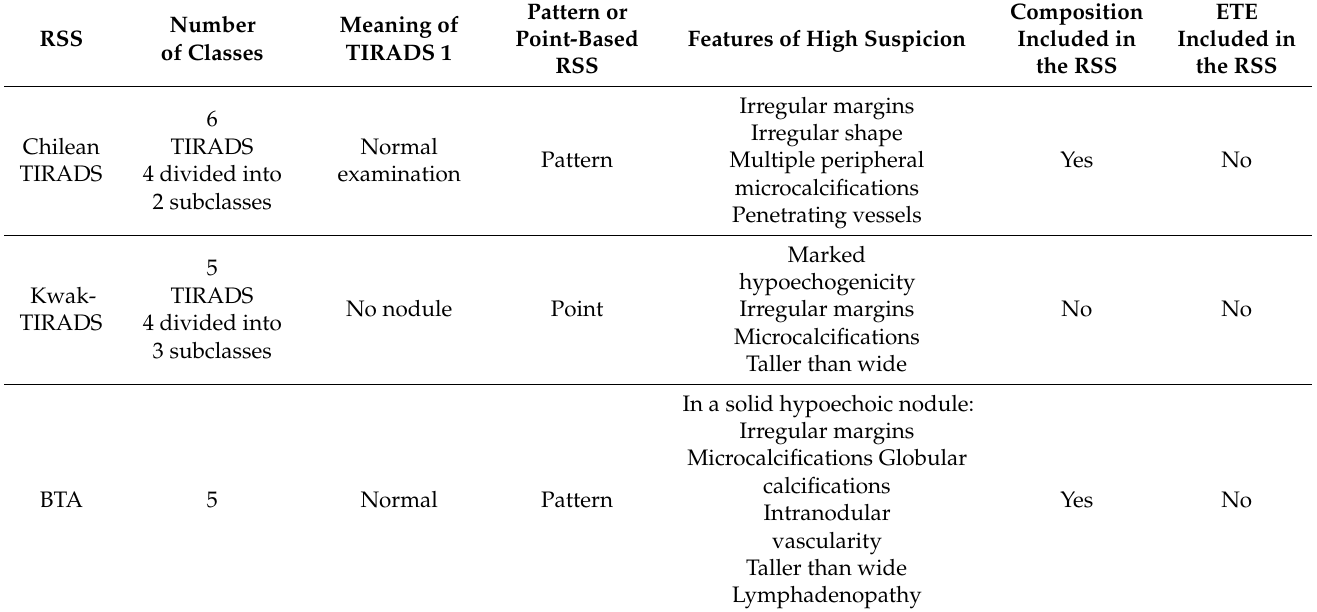
Table 1. Comparison of some specificities of existent risk stratification systems (RSSs). Note: ETE = extra-thyroidal extension; RSS = risk stratification